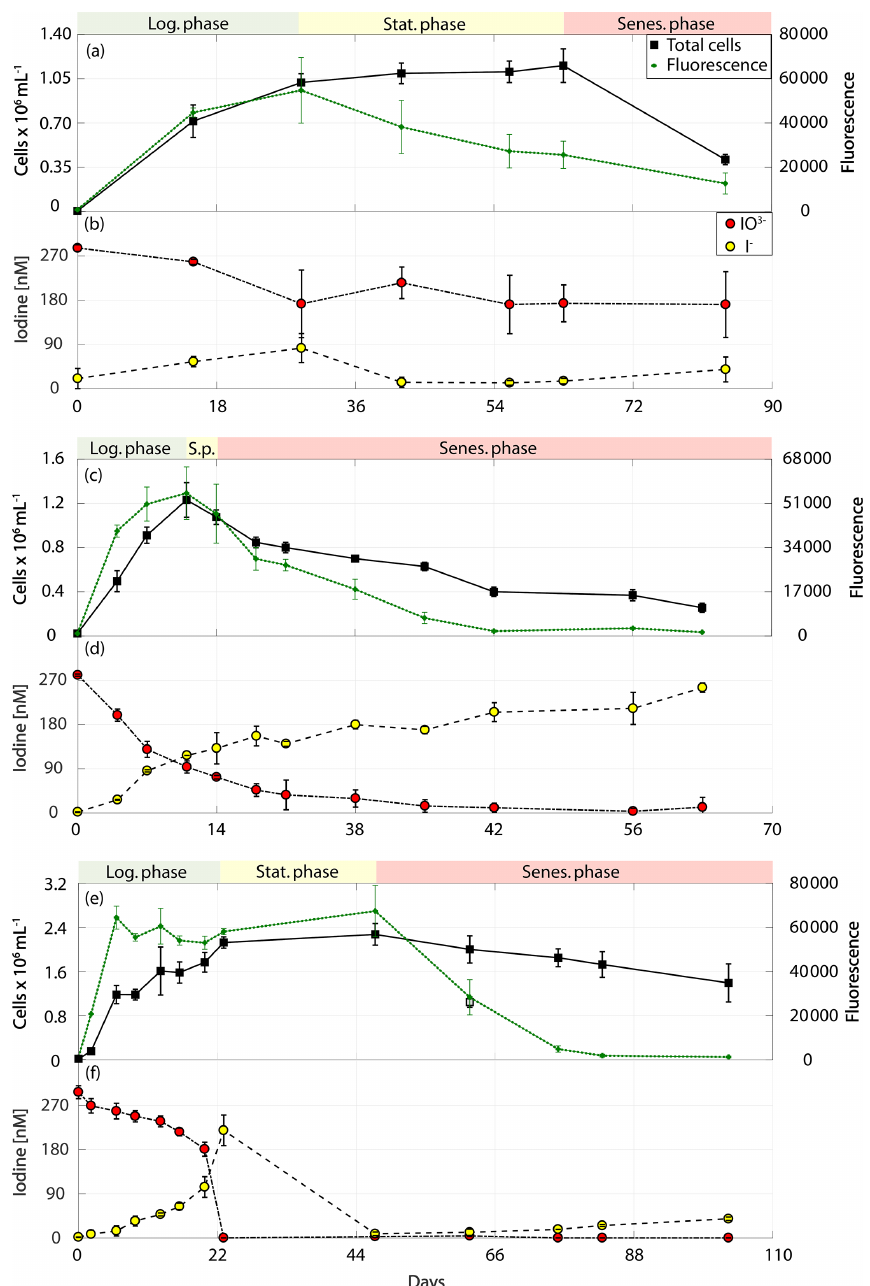
Figure 2. Total cell counts (black – total) and fluorescence readings (green) as well as inorganic iodine speciation (red – iodate, yellow – iodide) over the course of the growth curve experiments of diatoms for Chaetoceros gelidus (RCC 4512) in (a) and (b) , Chaetoceros sp. (RCC 4208) in (c) and (d) , and Chaetoceros sp. (CCMP 1690) in (e) and (f) . The colour-shaded bars on top of each graph indicate where the logarithmic phase (green), the stationary phase (yellow) and the senescent phase (red) began and ended based on total cell counts and fluorescence. Values depicted are means from culture replicates, with error bars indicating the standard deviations of these